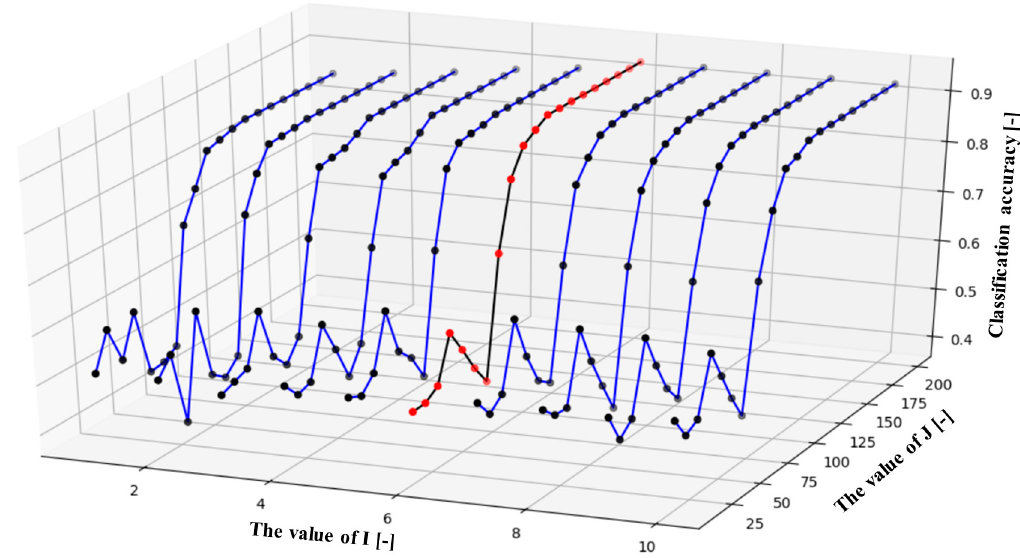
ff erent I and J on the classification Figure 12. The influence of different I and J on the classification accuracy. Figure 12. The influence of di